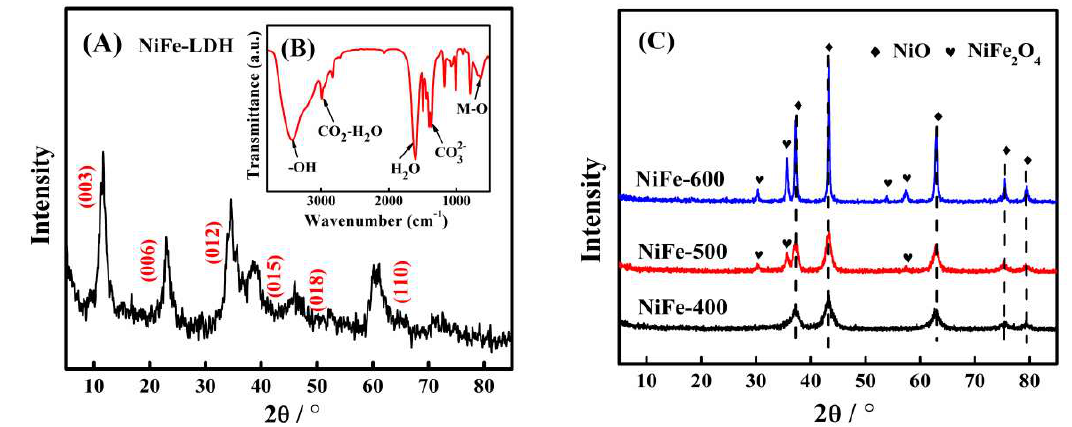
Figure 2. XRD pattern ( A ) and FT-IR spectrum ( B ) of NiFe- layered double hydroxide (LDH) precursor; XRD patterns of NiFe-LDO catalysts ( C ).